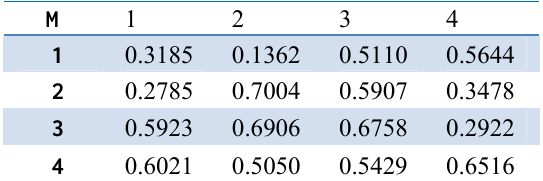
Table 2 Gaussian normalized image entropy matrix of Table